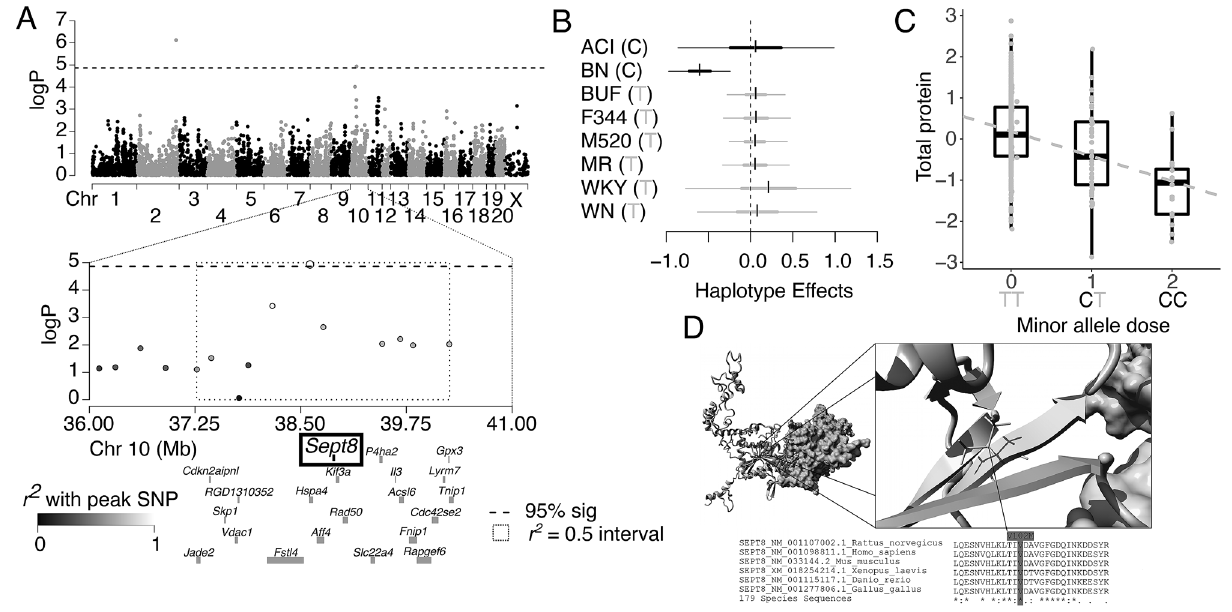
Figure 3. Genome-wide scan and founder effects at the chromosome 10 QTL for UPE followed by protein modeling of SEPTIN8. ( A ) Genome scan for urinary protein shows significant loci on chromosomes 2 and 10. The x-axis is the position on the chromosome, and the y-axis is the − log 10 P level of association. Genome- wide significance thresholds were calculated using parametric bootstraps from the null model. Linkage disequilibrium support interval (highlighted as a dashed line box) for the chromosome 10 locus is 2.99 Mb. Annotation of a sub-set of the 50 genes in this region are shown below the plot. ( B ) Additive haplotype effects were estimated using the Diploffect model, which takes into account uncertainty in haplotype state. Single- nucleotide polymorphism (SNP) allele information is overlaid on the haplotype effects, with minor allele in black and major allele in gray. The BN haplotype significantly decreases urinary protein at this locus, with high uncertainty from the ACI haplotype. Both BN and ACI share the C allele at this locus. ( C ) Effect of genotype at the peak marker on urinary protein showing that the C allele decreases urinary protein. ( D ) Protein modeling for SEPTIN8. Variant V102M of SEPTIN8 falls within a hydrophobic core near the SEPTIN8 dimer contacts. A zoomed in view is shown to the right. The bottom panel shows sequence alignments of amino acids in multiple species. SEPTIN8 amino acid 102 is 100% conserved as a V throughout 179